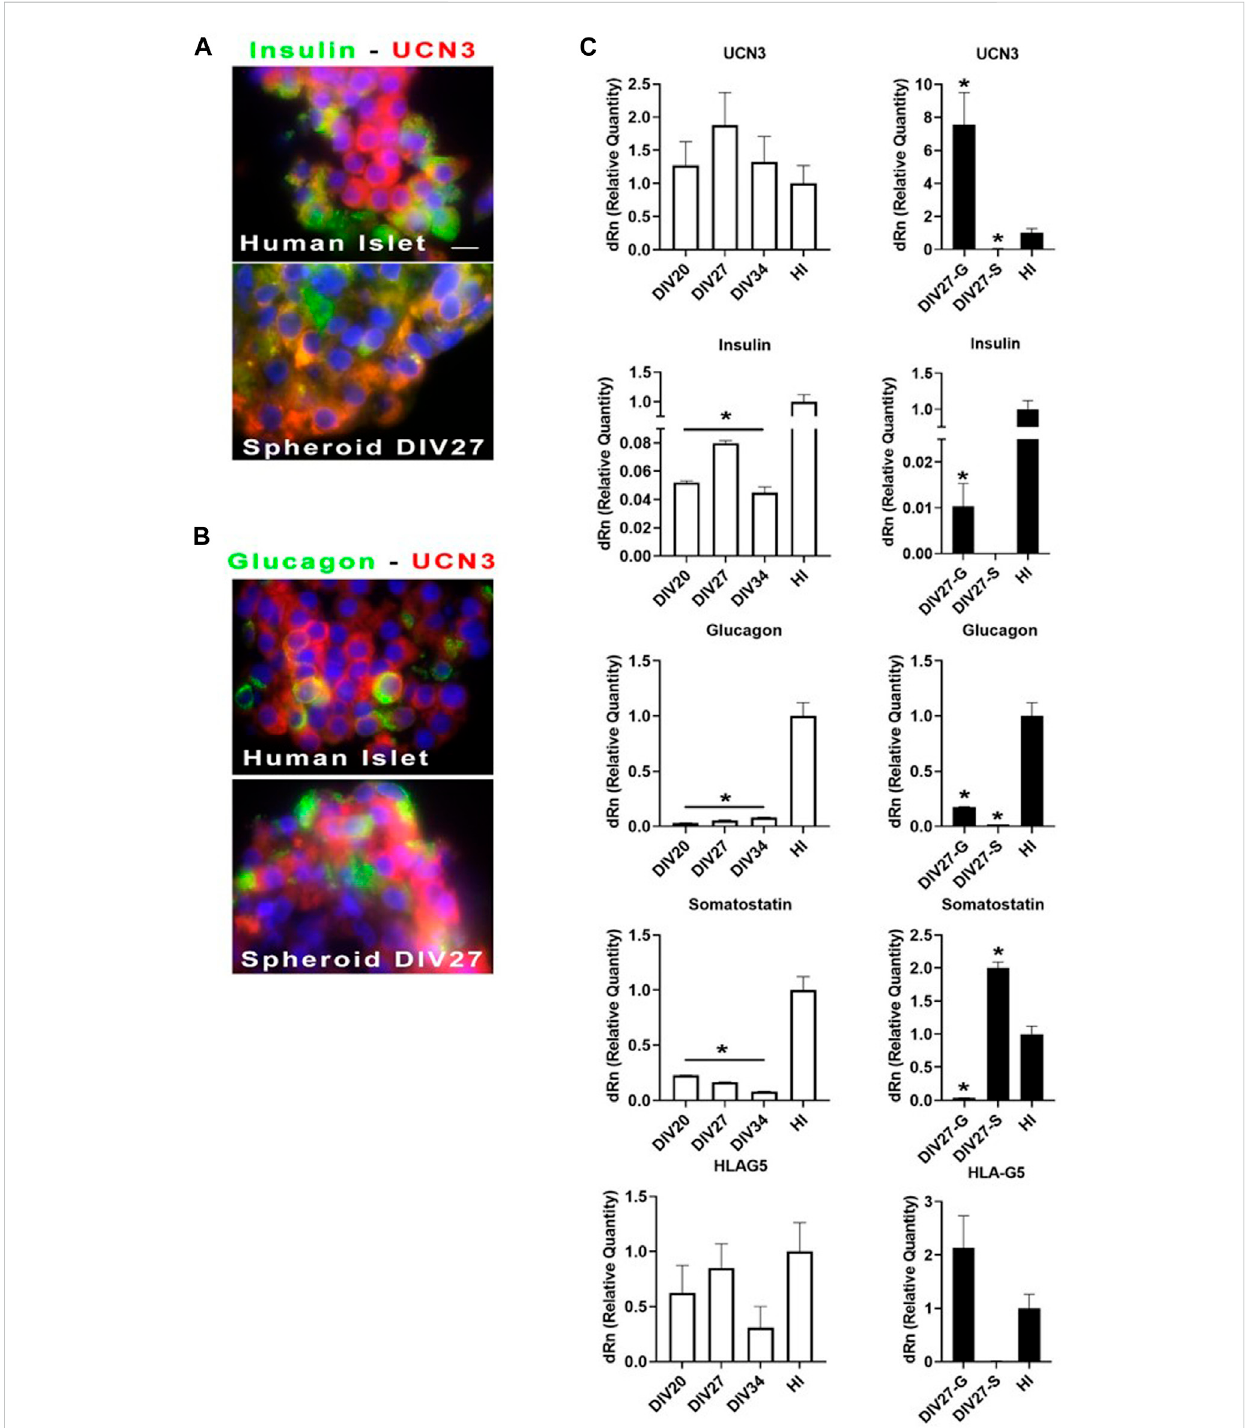
FIGURE 3 (A, B) Immuno fl uorescence analysis of cell spheroids at Div27 for the indicated antibodies in comparison with human islets (100X). Orange merging color (between green and red) might suggest although not prove that UCN3 co-localize with insulin and glucagon. (C) qPCR for the indicated messengers: white histograms showed relative quantity of the selected messengers for the three times of terminal differentiation stages as compared with whole human islets. Div27 looked the best differentiation time; black histograms showed that differentiation at Div27 was more oriented toward glucagon (Div27-G) or somatostatin (Div27-S) production in comparison with human islets * p <